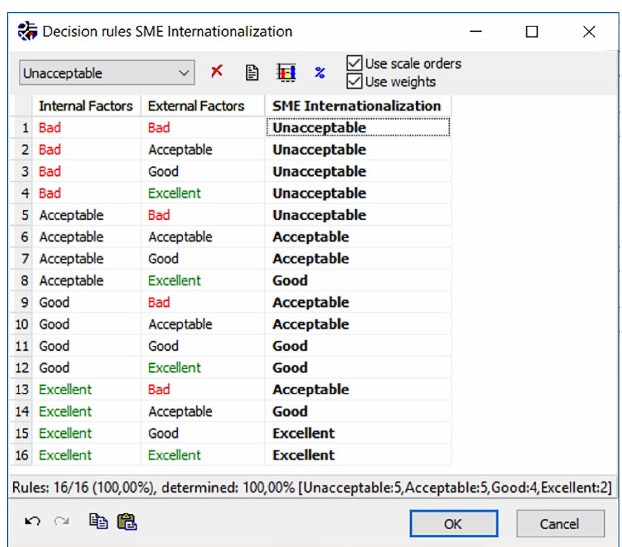
Figure 7. Utility function for SME internationalization